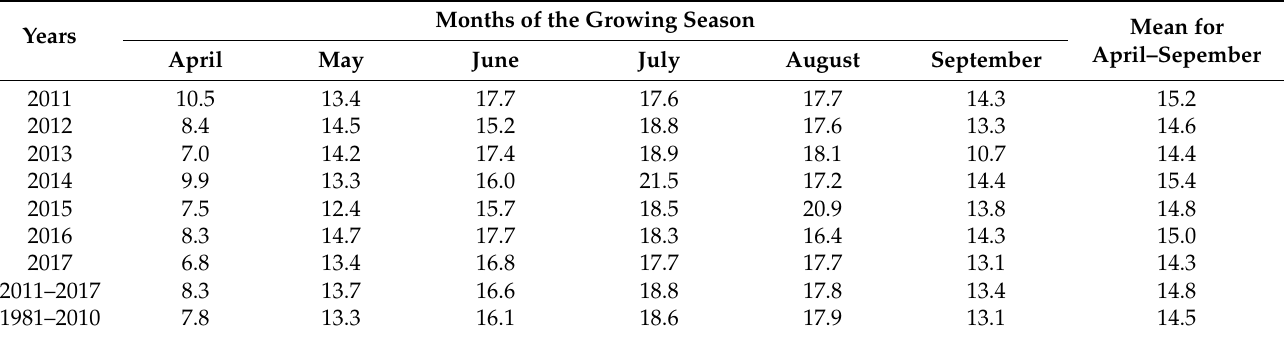
Table 1. Air temperature in the years 2011–2017 ( ◦ C).